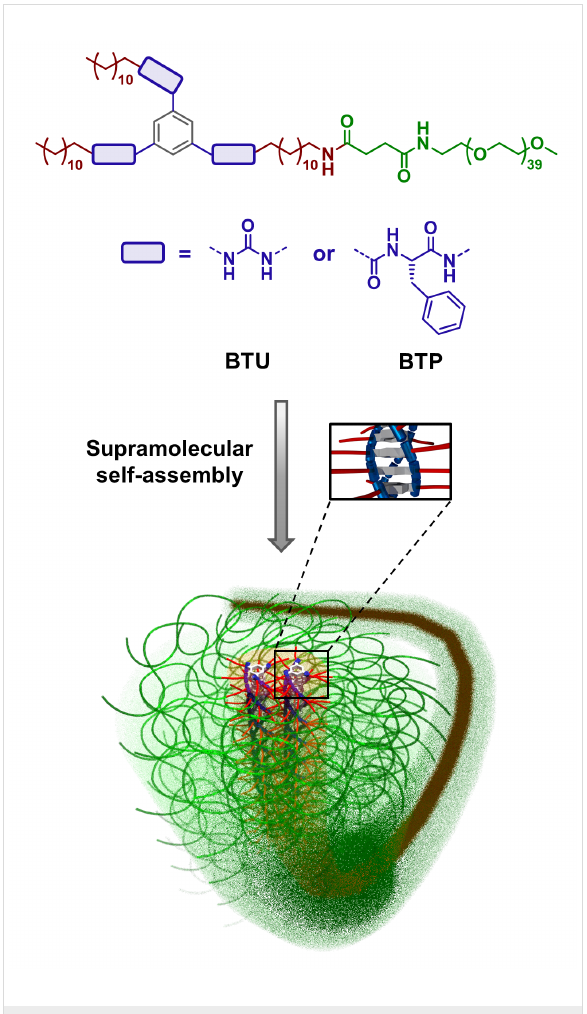
Figure 1: Schematic representation of the chemical structures of BTU and BTP and the supramolecular self-assembly of the compounds into